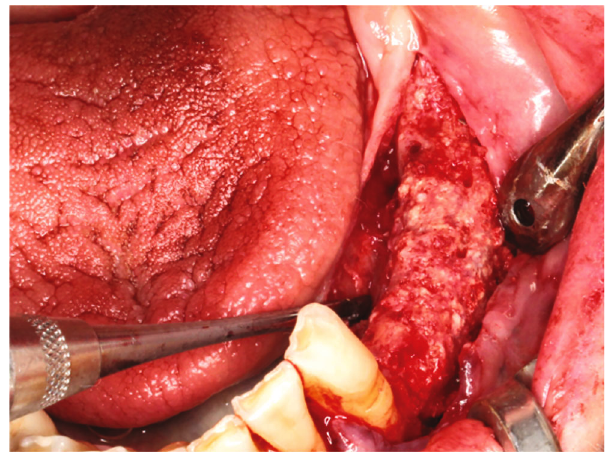
Figure 17: Ossi fi ed graft after YxOss CBR® titanium mesh